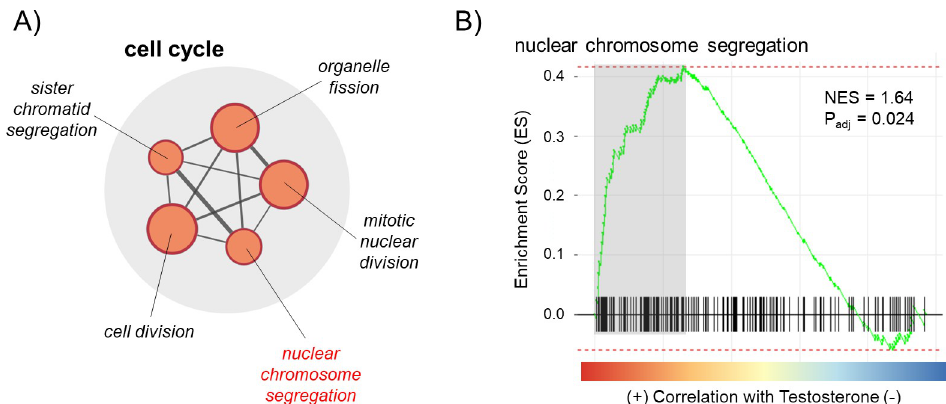
Fig 3. (A) Enrichment Map showing a functional group of gene sets related to cell cycle that were detected in a Gene Set Enrichment Analysis (GSEA) comparing testosterone- versus control-treated hens, one of which was nuclear chromosome segregation (highlighted in red). Only gene sets with p adj < 0.05 are included. Node size corresponds to gene set size. Normally, color would designate the direction the gene sets were altered (red = enriched in testosterone- treatment, blue = depleted in testosterone-treatment), but in this case, all were enriched in samples from testosterone- treated hens, so all are red. Line thickness connecting the gene set nodes represents the degree of gene overlap between the two sets. (B) GSEA enrichment plot for a select gene set. Black bars represent the position of members of the gene set in the ranked list together with the running enrichment score (ES; plotted in green). The adjusted p-value and normalized enrichment score (NES) are presented. Leading edge genes (i.e., those that contribute most to the ES) are highlighted in gray and can be found in S2 Table.